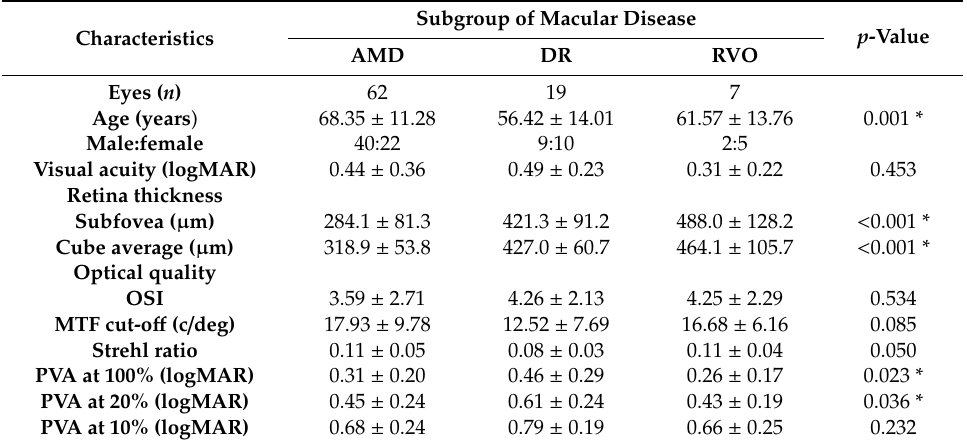
Table 2. Comparison of subgroups of three di ff erent diseases including age macular degeneration, diabetic retinopathy, and retinal vein occlusion.